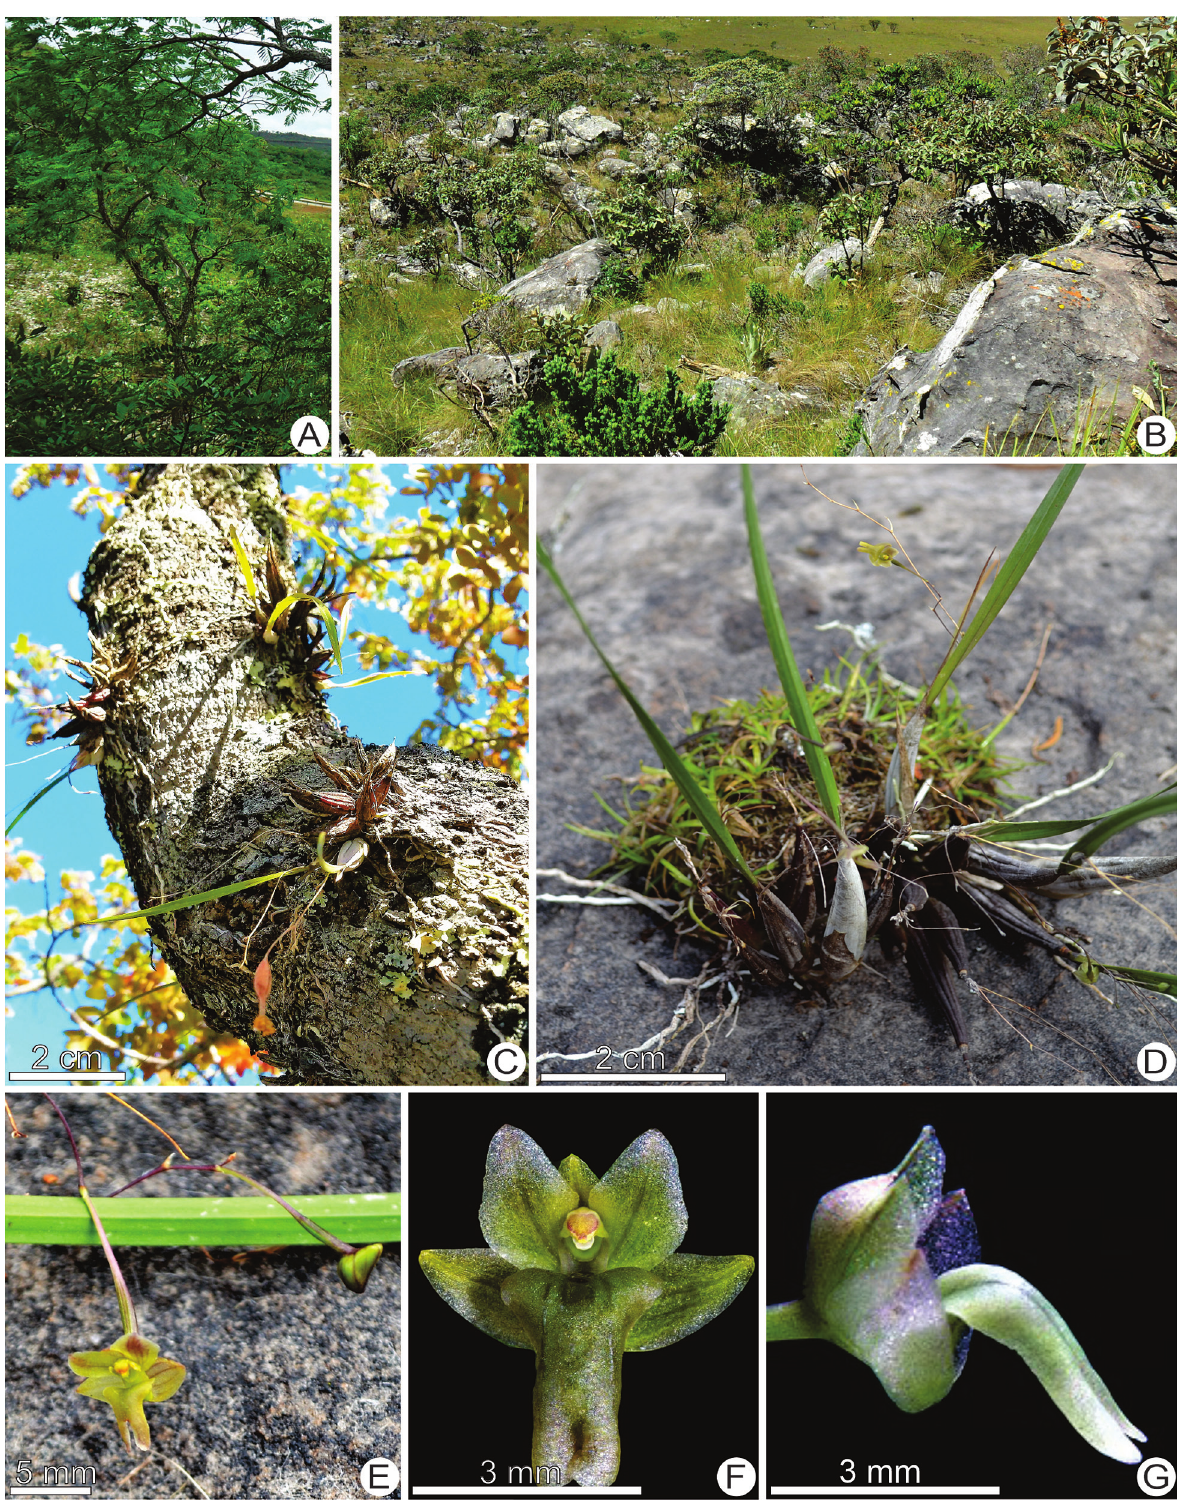
Figure 3. Scaphyglottis livida (Lindl.) Schltr. A, B. Habitats: ( A ) gallery forests; ( B ) Cerrado rupestre. C, D. Habit. E. Detail of the inflores- cence. F. Flower, frontal view. G. Flower lateral